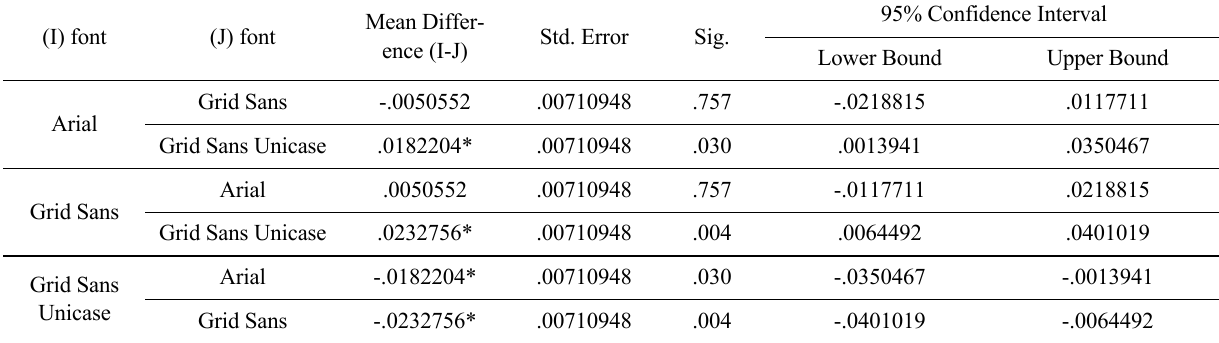
Table 3. Tukey’s Post Hoc test results. (I)